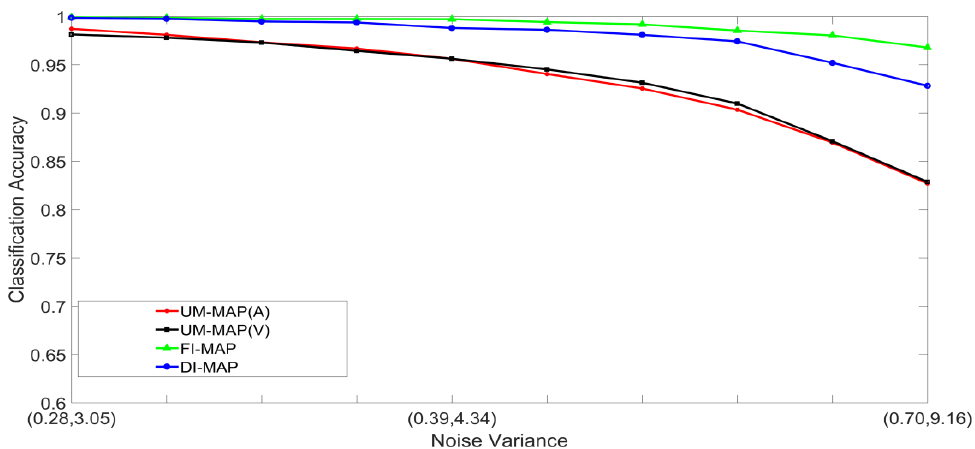
Figure 8. Classification accuracy, as a function of noise, for the MAP-based classification systems.